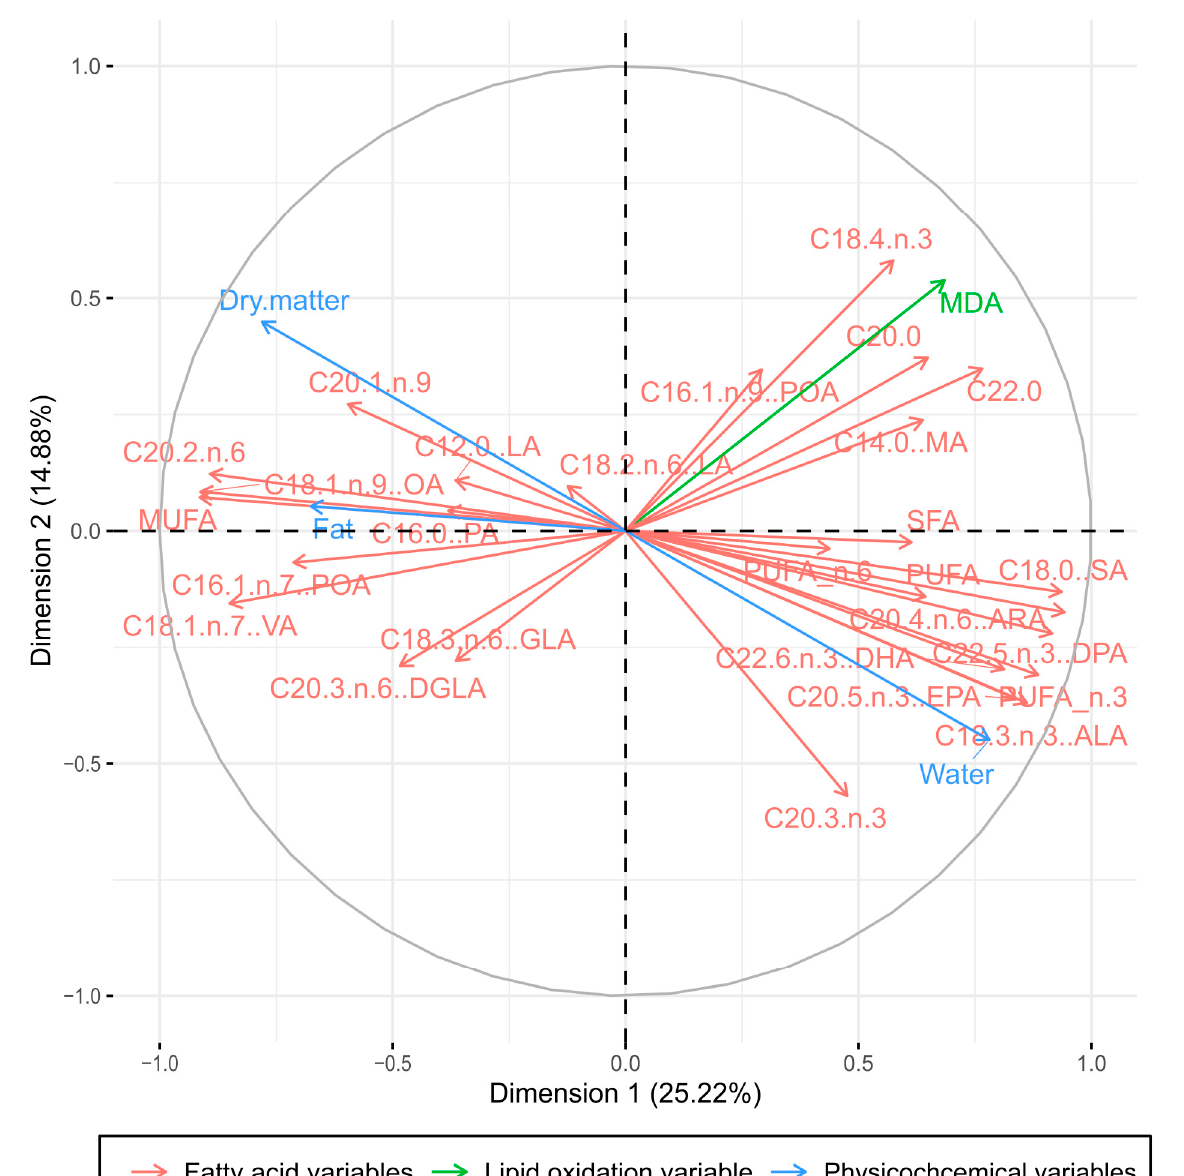
Figure 2. The correlation circle of analyzed variables.